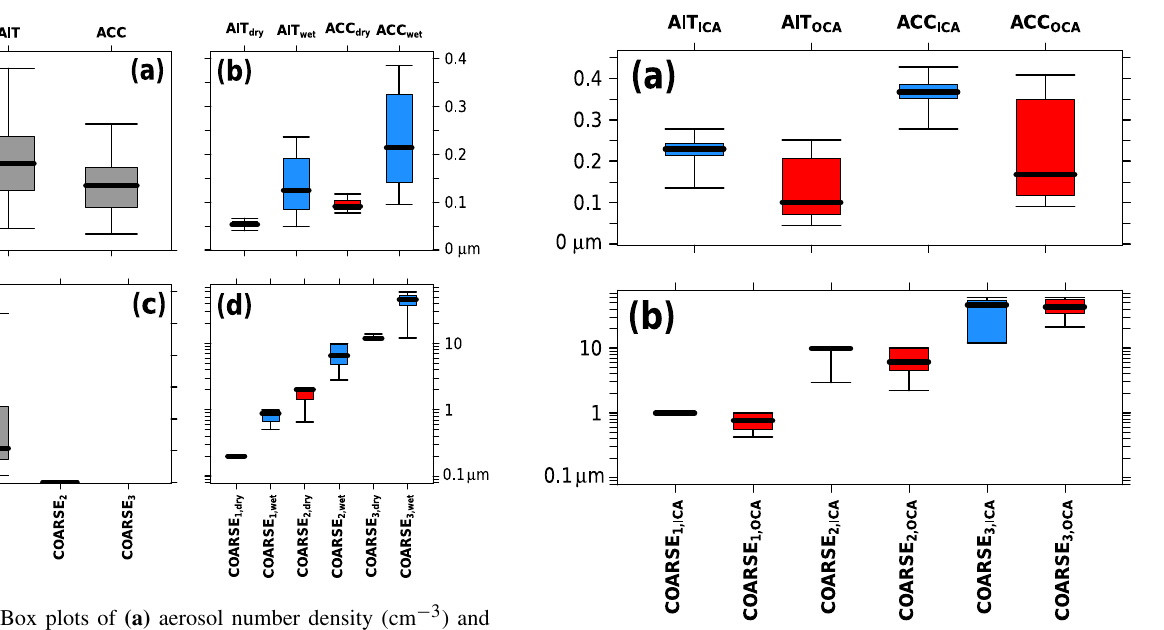
Figure D2. Box plots of aerosol wet diameters (µm) for (a) AIT and ACC and (b) COARSE split into the three COSMO-ART sea salt modes as a median in the lowest 1500ma.g.l. over the Ivory Coast (7.5–3 ◦ W, 4–10 ◦ N) on 3 July, 06:00UTC by separating into ICA (areas with nonzero cloud water, blue) and OCA (areas with zero cloud water, red). The whiskers span the data from percentile 2.5 to 97.5 (95% of the data). Data outside of this range are not